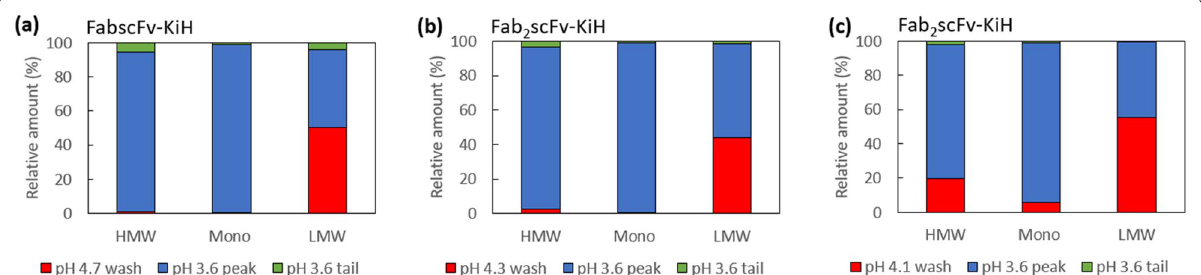
Fig. 7 Analysis of the relative amount of HMW, monomer and LMW species in the intermediate low-pH wash, pH 3.6 eluate peak and tail process fractions for the Protein A run of a FabscFv-KiH with pH 4.7 intermediate wash, b Fab 2 scFv-KiH with pH 4.3 intermediate wash and c Fab 2 scFv-KiH with pH 4.1 intermediate wash. The area under the HPLC-SEC curve for HMW, monomeric and LMW species was multiplied by the volume collected during the Protein A chromatography run for each process fractions. The resultant value obtained for each species was summed up across all process fractions and taken as